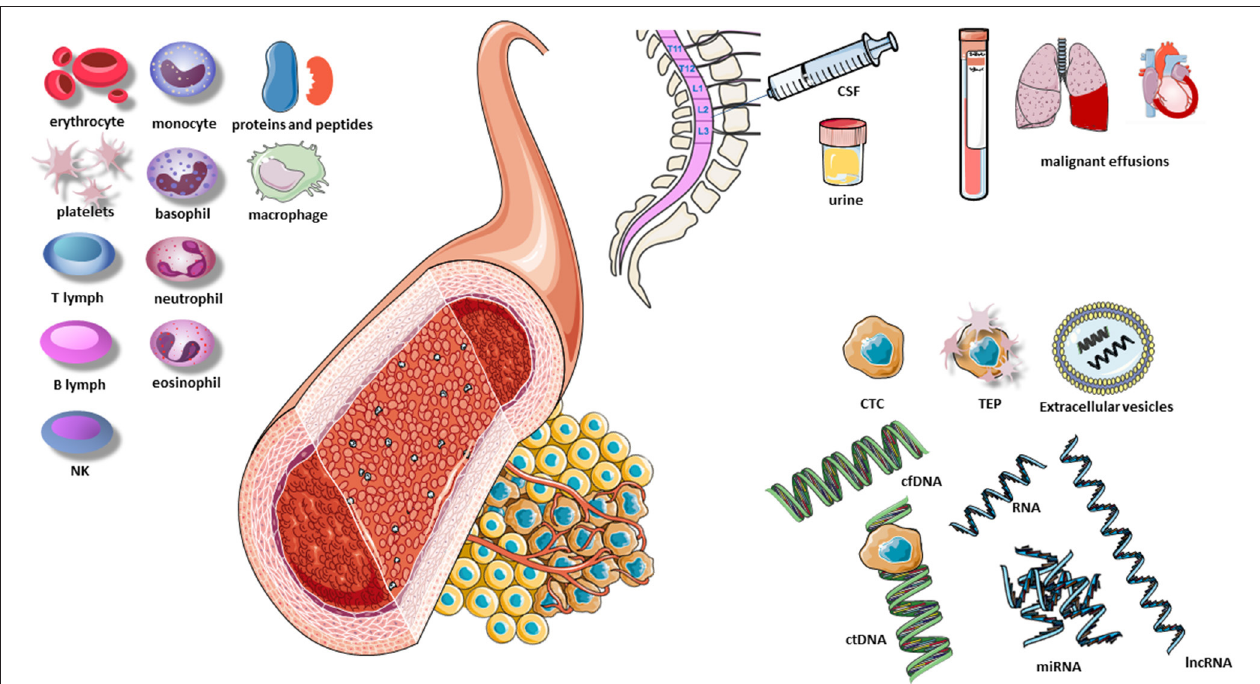
FIGURE 1 | Elements of the liquid biopsy. B lymph, B lymphocyte; CSF, cerebrospinal fluid; cfDNA, cell-free DNA; CTC, circulating tumor cells; ctDNA, circulating tumor DNA; lnc RNA, long non-coding RNA; NK, natural killers; TEP, tumor-educated platelets; T lymph, T lymphocyte; miRNA, microRNA. Extracellular vesicles include exosomes, microvesicles and apoptotic